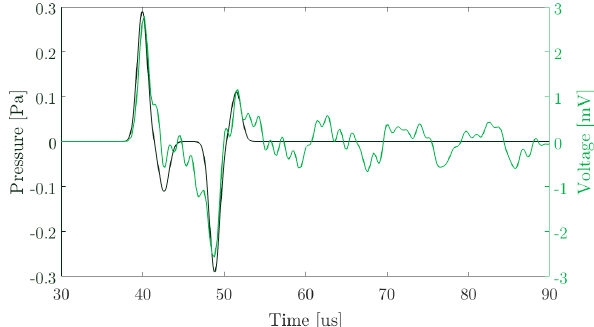
Figure 9. Pressure and terminal voltage for the optimized piezoelectric ceramic for a pressure signal in the emitted source as shown in Figure 5a. The propagated pressure on the sensor surface is 0.28 Pa as shown in Figure 7a.